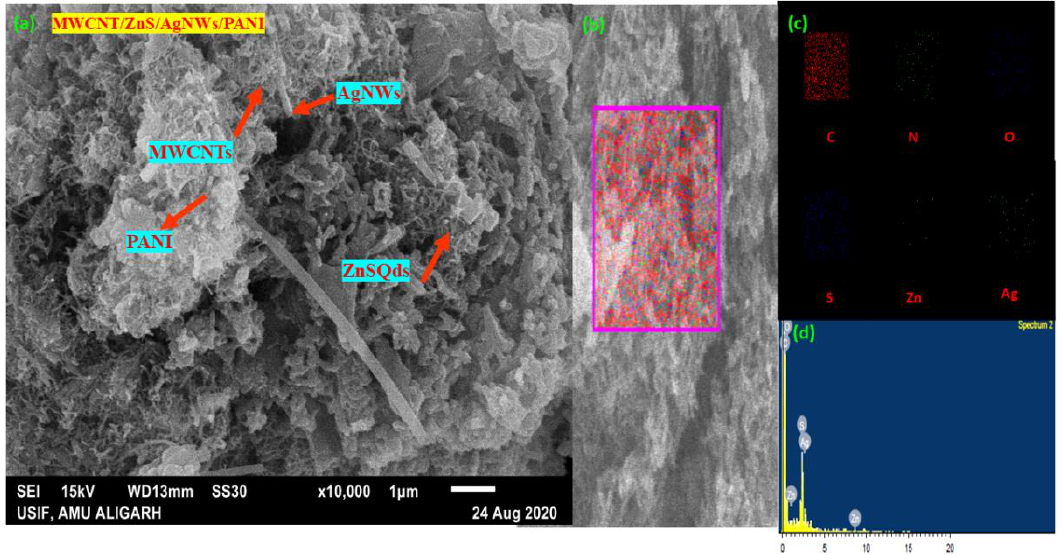
Figure 6. SEM images of: ( a ) (MWCNT/ZnS/AgNWs/PANI) nanocomposite; ( b , c ) mapping of nanocomposite. ( d ) EDX of